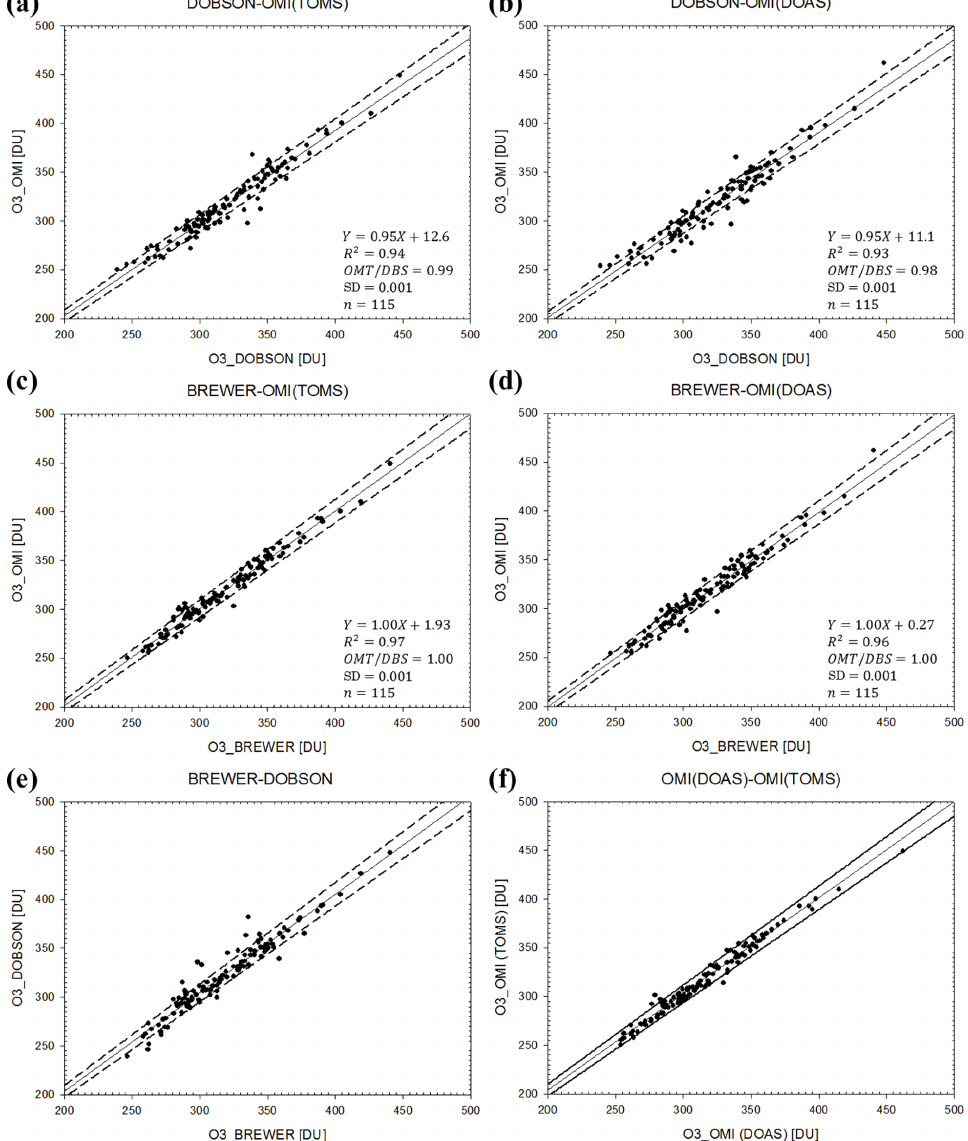
Figure 4. Intercomparison of daily TCO values between (a) Dobson (DBS) and OMI-TOMS (OMT), (b) Dobson (DBS) and OMI-DOAS (OMD), (c) Brewer (BRE) and OMI-DOAS (OMD), (e) Brewer (BRE) and Dobson (DBS), and (f) OMI-DOAS (OMD) and OMI-TOMS